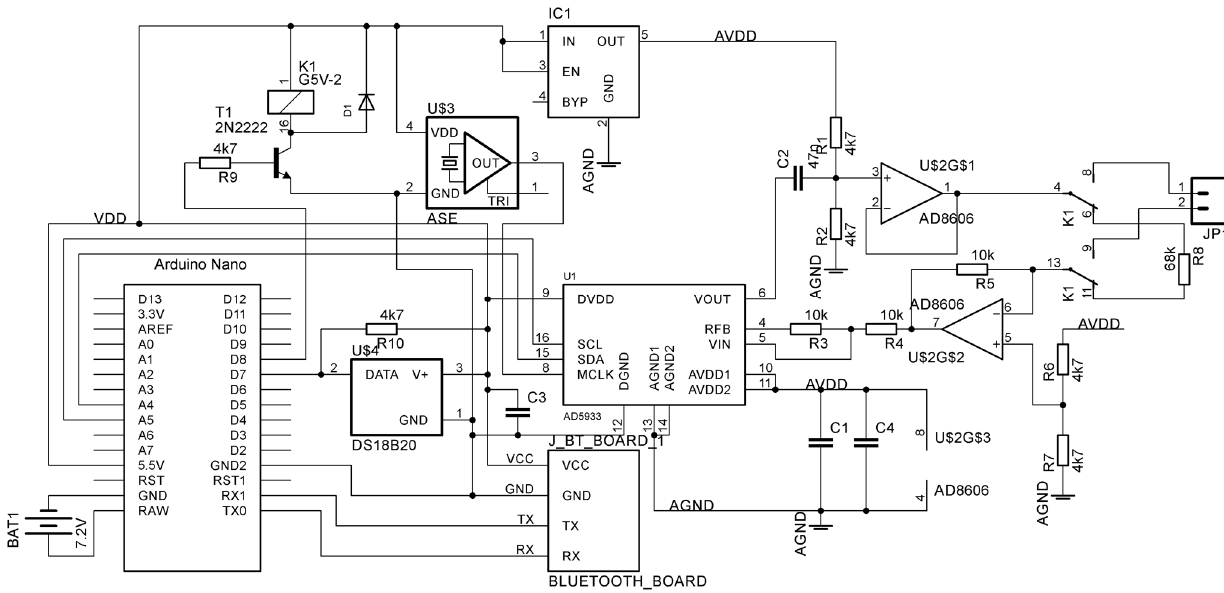
Figure 2. Circuit diagram of the device for complex resistance (impedance) measurements.